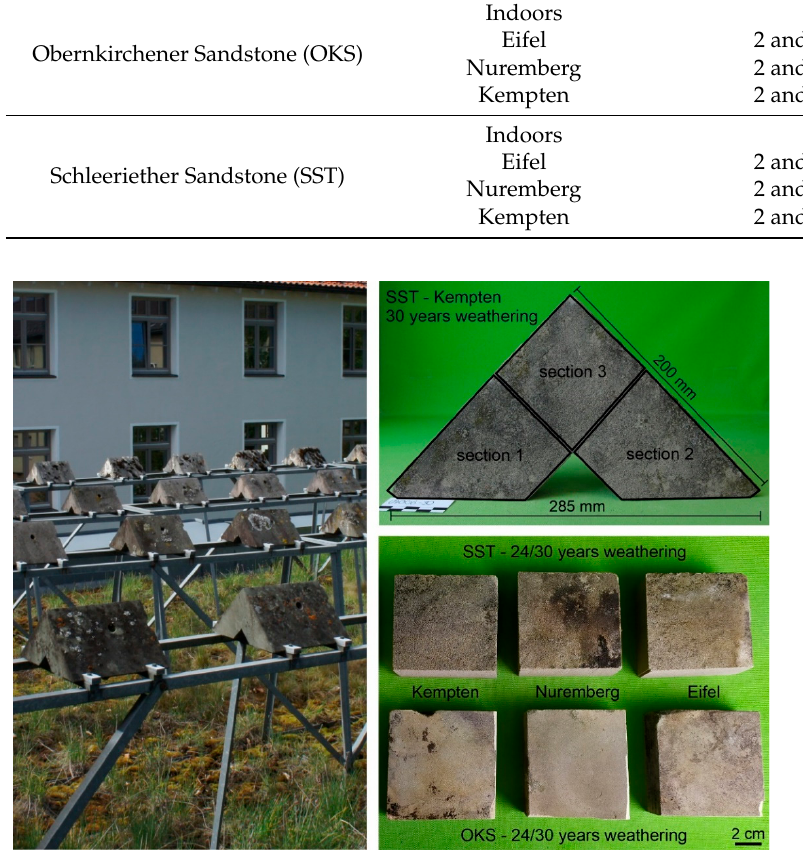
Figure 1. Left : exposure site in Kempten, situated on the roof of a tree nursery (residential area). Top right : sample preparation after 2 and 24/30 years of exposition. Bottom right : weathered sections of Obernkirchener and Schleeriether Sandstones due to long-term exposure.